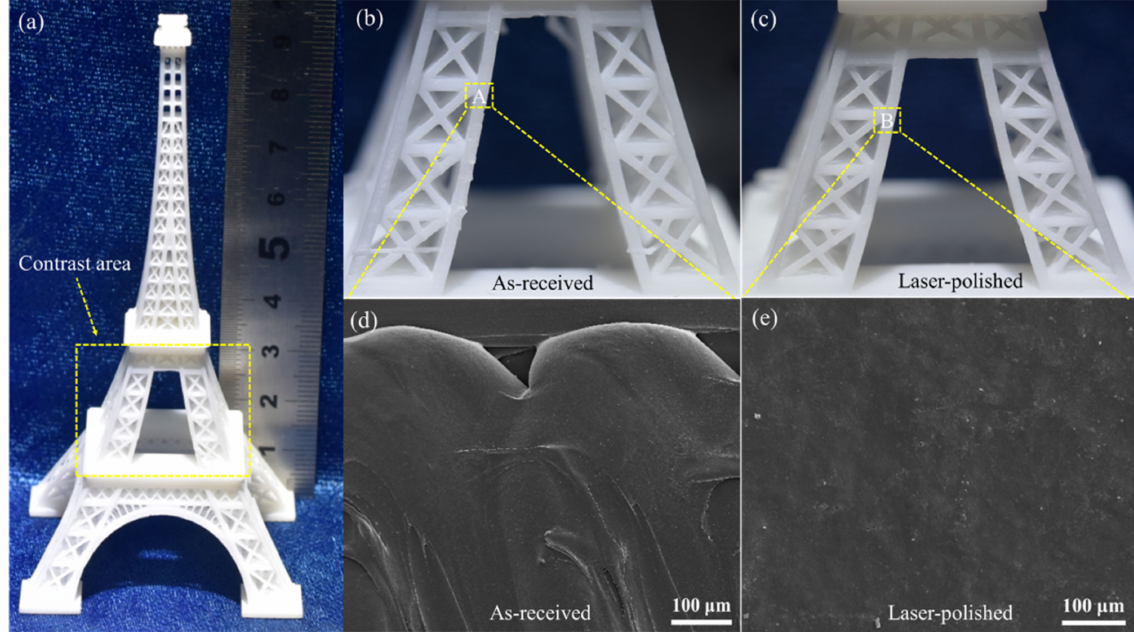
Figure 8. The surface morphology before and after laser polishing of the landscape design example: ( a ) 3D-printed PLA Eiffel Tower; ( b ) as-received specimen; ( c ) laser-polished specimen; The bottom panels ( d , e ) correspond to the top panels ( a , b